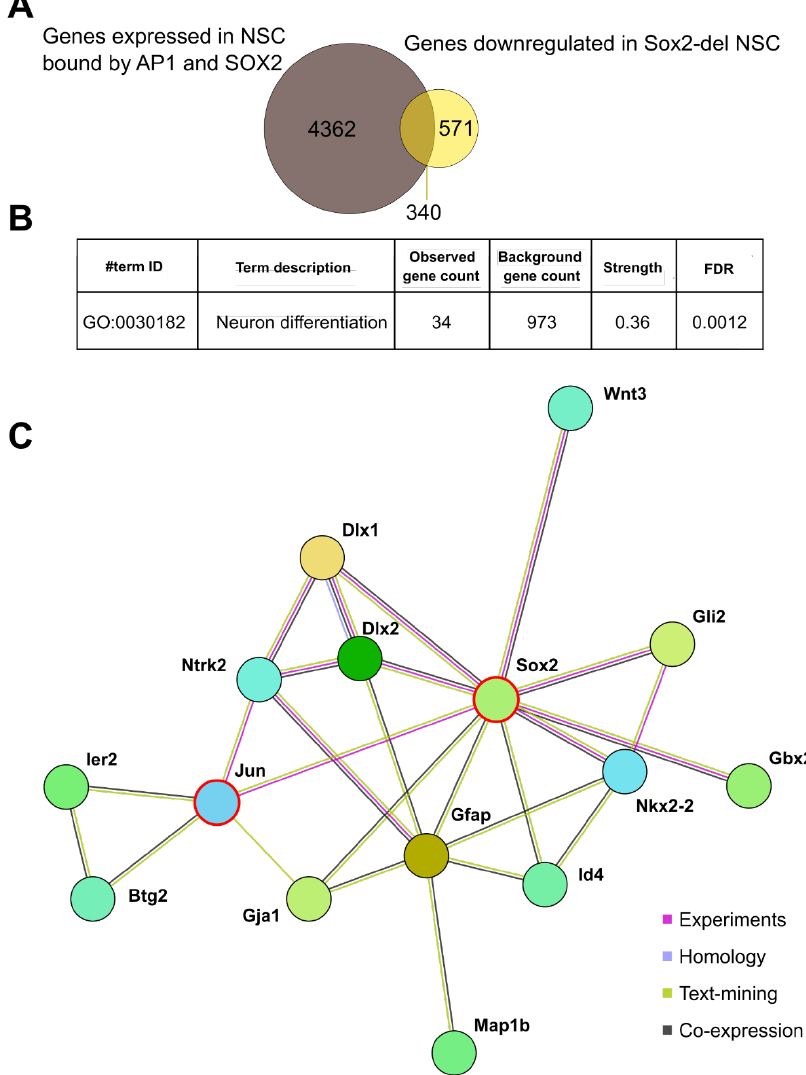
Figure 6. SOX2 and AP1 co-regulate genes involved in neuronal differentiation. ( A ) Expressed genes bound by AP1 and Sox2 were overlayed with genes that are significantly downregulated (fold change > 2; TPM > 1) upon knockout of Sox2 in NSC [8] (see also Table S5). ( B ) An interaction network was generated using STRING, and a gene ontology enrichment was performed, showing 34 genes with the GO:term Neuron differentiation. The largest cluster was isolated, and in that cluster were 18 genes with the GO term neuronal differentiation (see also Table S6). ( C ) Another gene-interaction network was generated, which represents a putative regulatory core of players governed by AP-1 and SOX2.